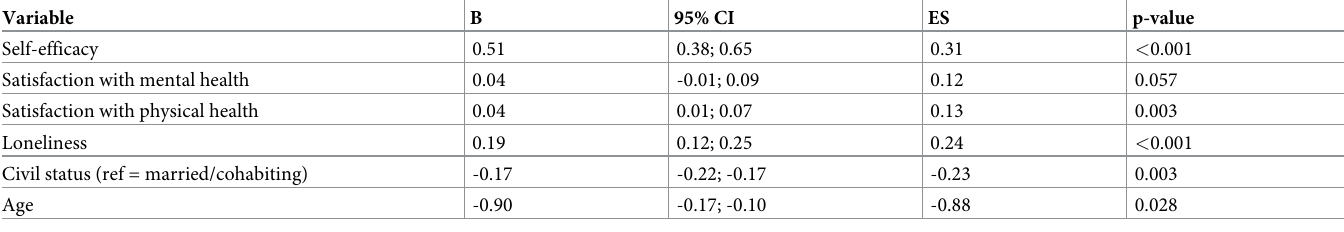
Table 3. Association between QOL and civil status, self-efficacy, loneliness, and mental and physical health examined by multivariate linear regression analysis.